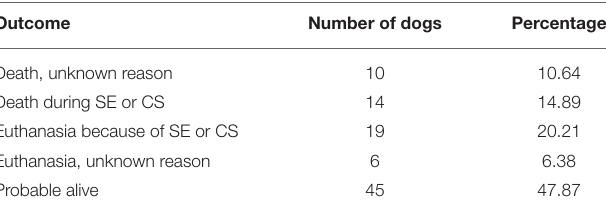
TABLE 2 | Survival rate of the entire study population at the time of evaluation; SE, status epilepticus; CS, cluster seizure.